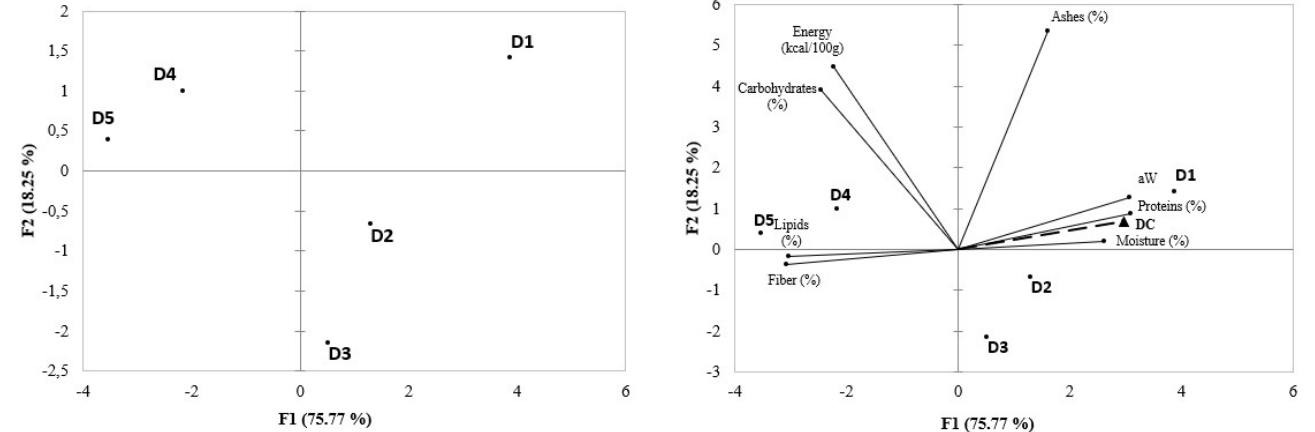
Figure 3. Analysis of main components of mass gain (DC) of Zophobas atratus larvae fed with a conventional diet with or without grape residue (D1 to D5) for 90 days and the parameters of the nutritional composition of the diets. Diets: D1 = 100% 70 g/100 g poultry feed and 30 g/100 g ground maize mixture (control); D2 = 75% D1 + 25% D5; D3 = 50% D1 + 50% D5; D4 = 25% D1 + 75% D5; D5 = 100% grape juice production residue.